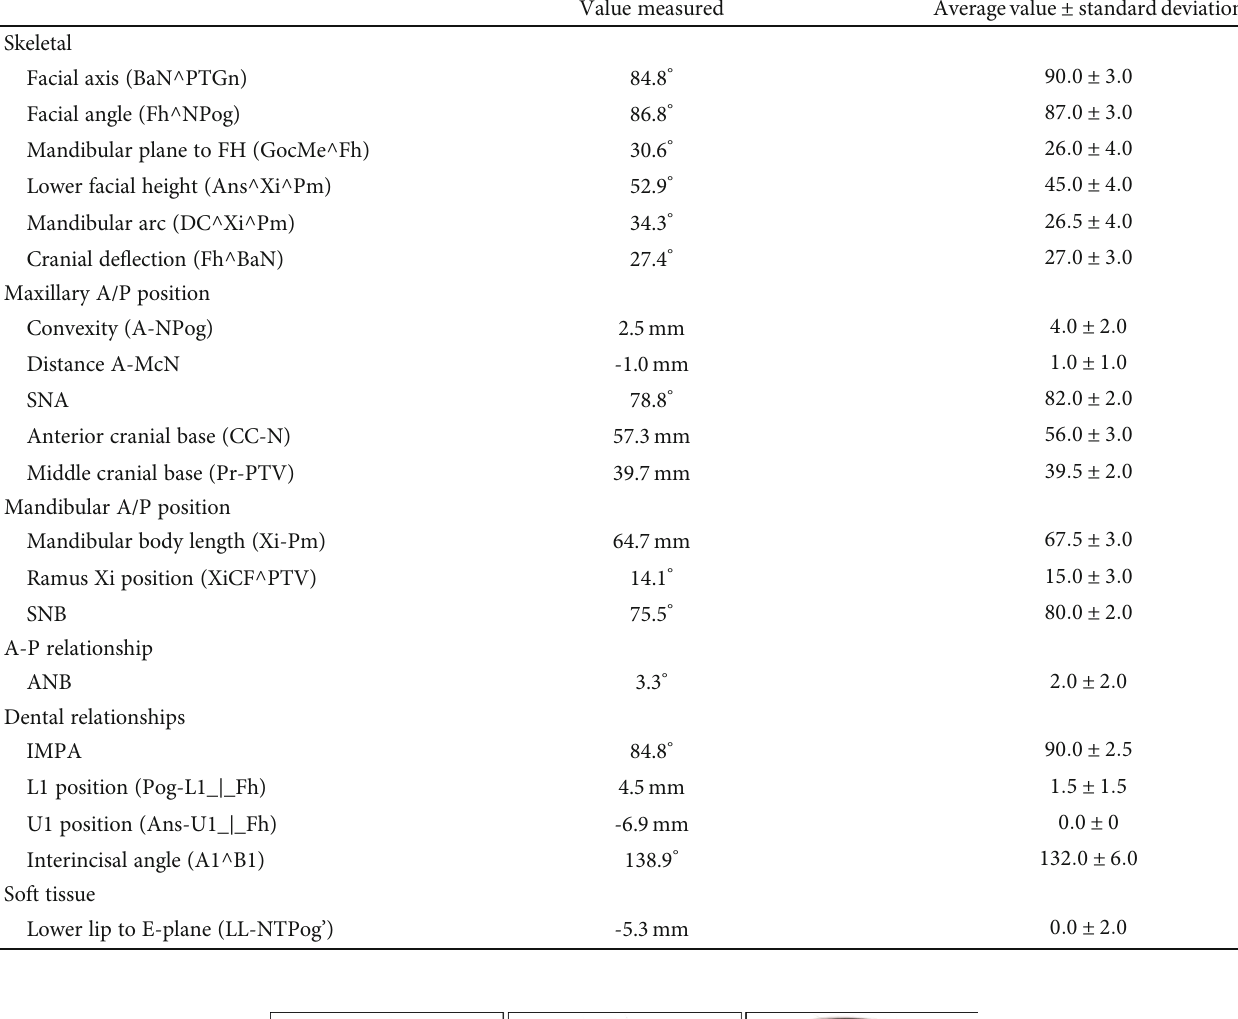
Table 2: Cephalometric values at the end of the treatment.